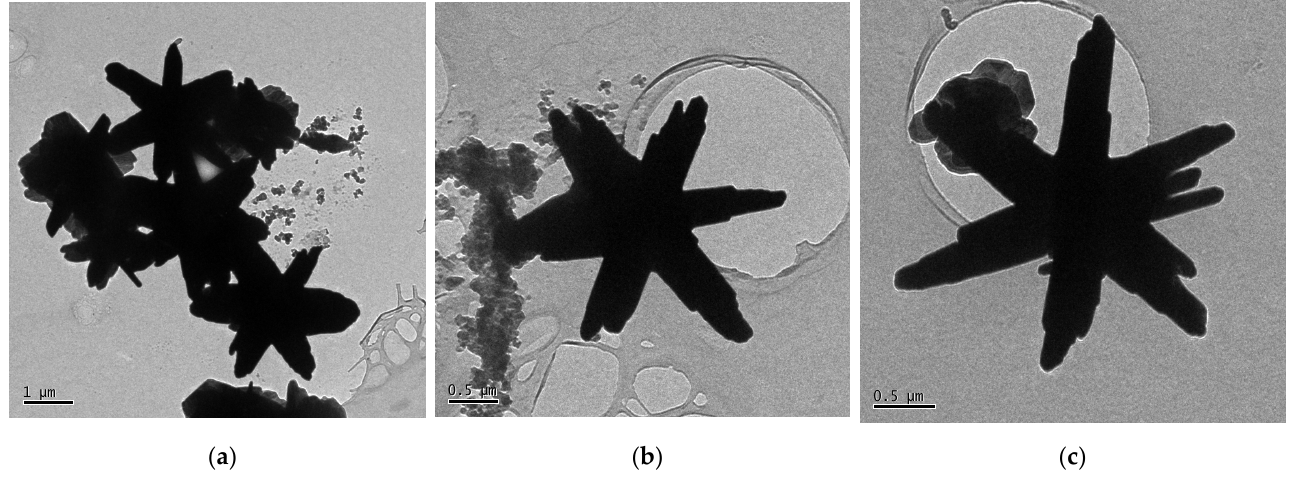
Figure 9. TEM micrographs of vanadium oxide V 6 O 11 rotationally symmetric six-folds (VOx-NC), the absence of pale fringes in the structures evidenced the disintercalation of long chain alkyl thiols: ( a ) clustered V 6 O 11 vanadium oxide six-folds; ( b , c ) isolated vanadium oxide six-folds.